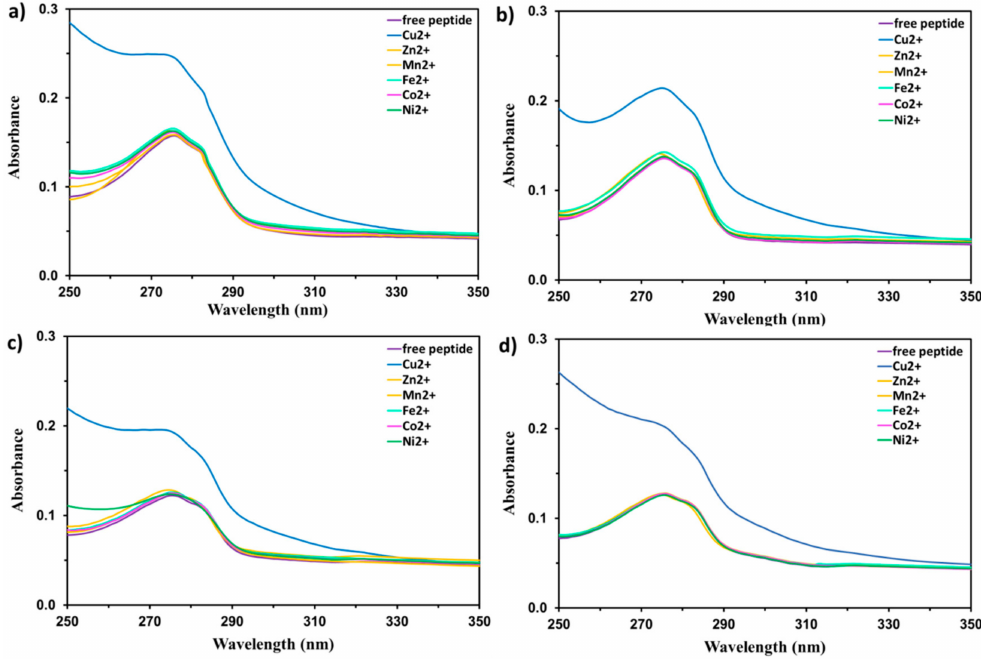
Figure 1. The UV absorption spectra of EYHHQ ( a ), EHYHQ ( b ), EHHQY ( c ), and KYHHE ( d ) (0.1 mM in 5 mM MES bu ff er, pH 6.0) in the absence of any ions (free peptide) as well as in the presence of Cu 2 + and other cations (80 µ M, molar ratio 1:0.8) including Mn 2 + , Fe 2 + , Co 2 + , Ni 2 + , and Zn 2 +